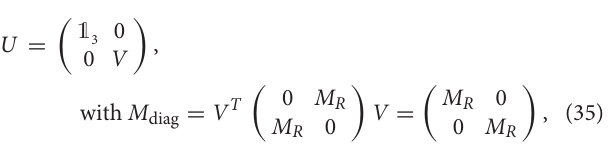
FIGURE 6 | Prediction for BR( H quantifies the agreement between both predictions. The particular seesaw scenario is defined in Equation (50), with Y 0 controlling the global strength of the Yukawa coupling. We consider degenerated heavy neutrinos in the left ( M R